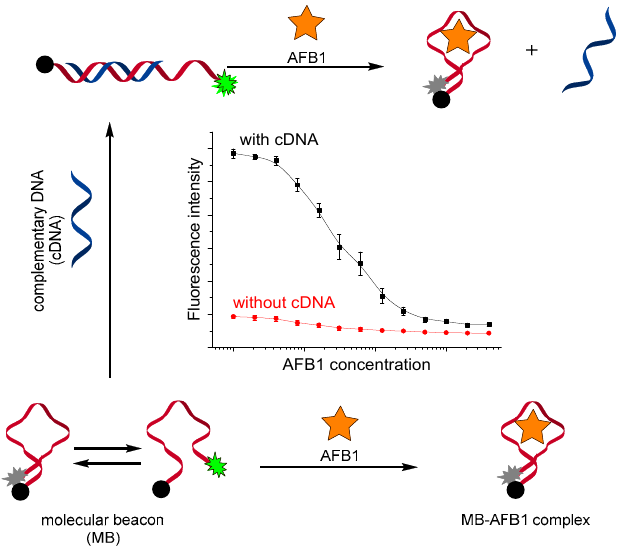
Scheme 1. Picture illustrating the principle of this proposal. With the assistance of a complementary DNA (cDNA) strand, the molecular beacon (MB) hybridizes with the cDNA to form a duplex